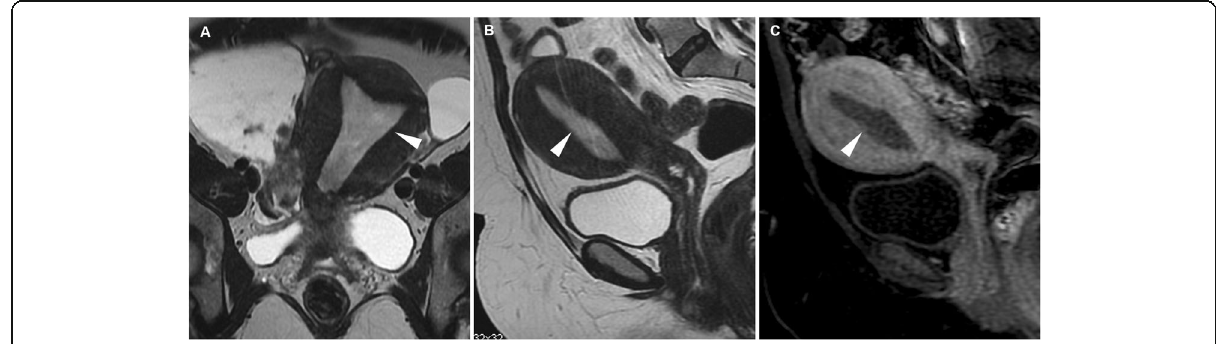
Fig. 2 Endometrial hyperplasia in a 43-year-old woman with acute abnormal uterine bleeding. Oblique-coronal ( a ), sagittal ( b ) T2-weighted images and gadolinium-enhanced sagittal ( c ) fat-suppressed T1-weighted image show marked endometrial thickening (arrowheads) without macroscopic signs of myometrial invasion. Hysteroscopy with endometrial biopsy demonstrated simple endometrial hyperplasia without